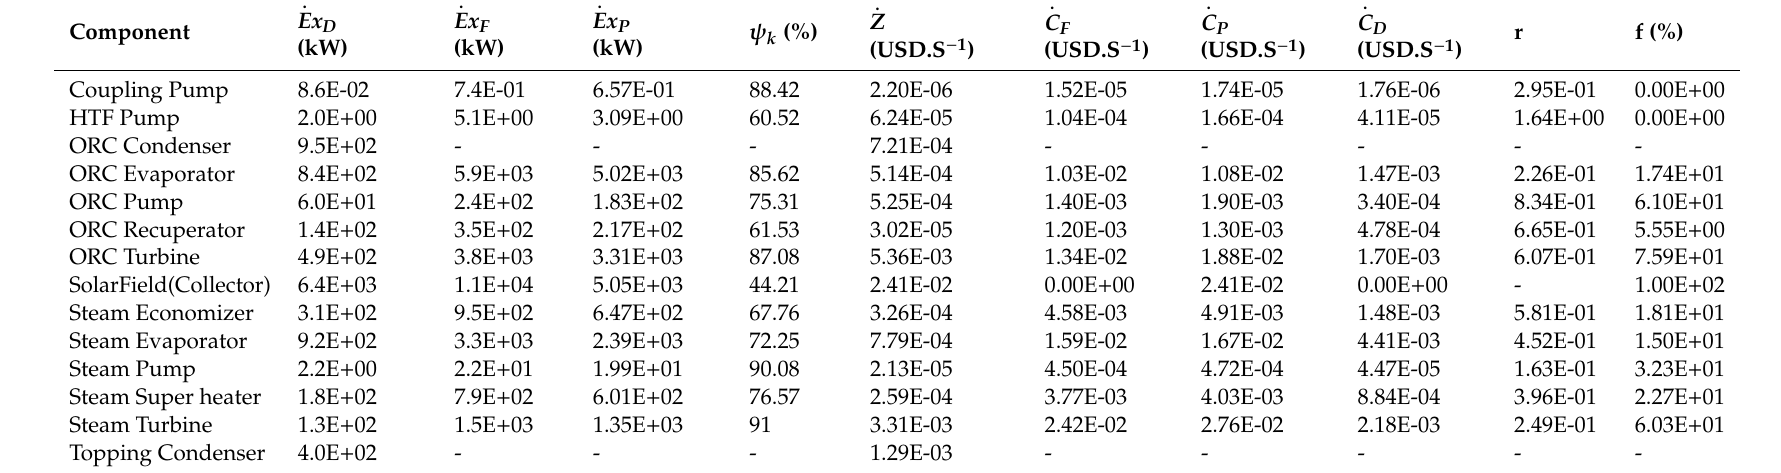
Table 10. The results of exergo-economic analysis of each component in the solar–geothermal cycle